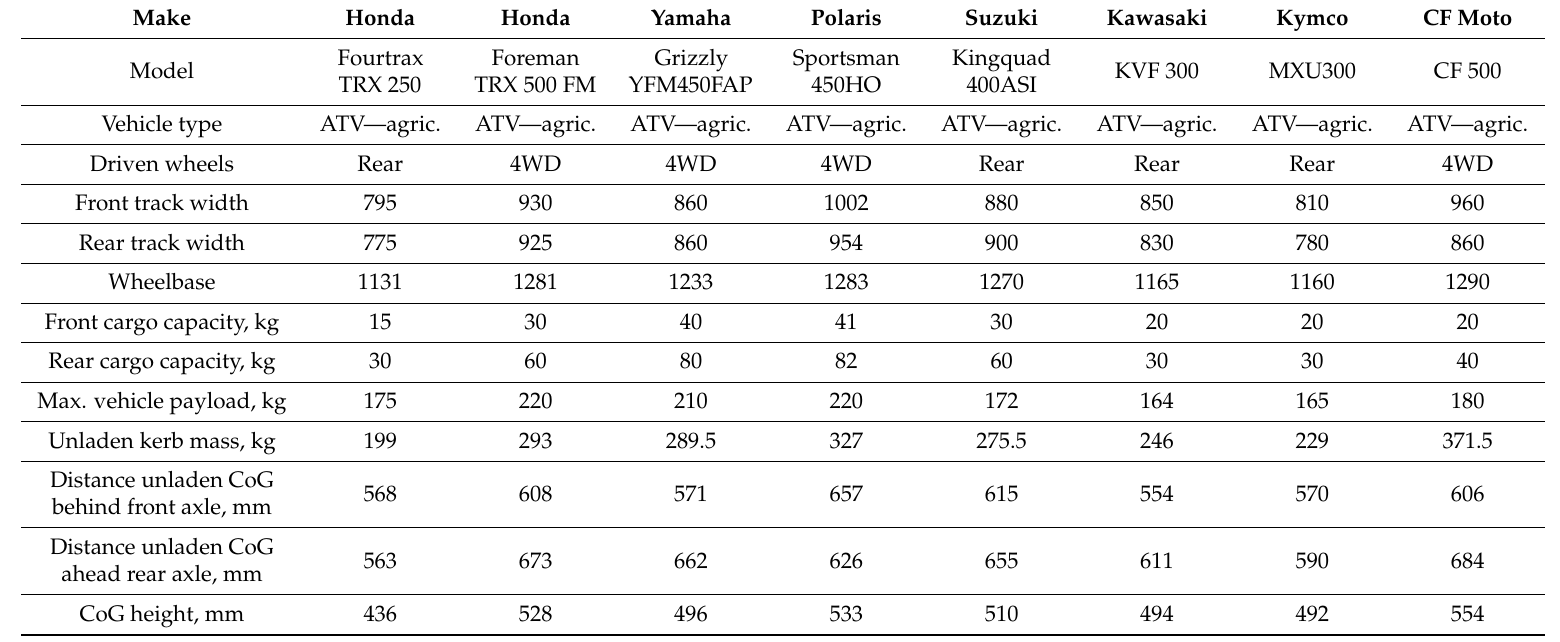
Table A1. Dimensional data for work Quad-Bikes—Adapted from Grzebieta et al.